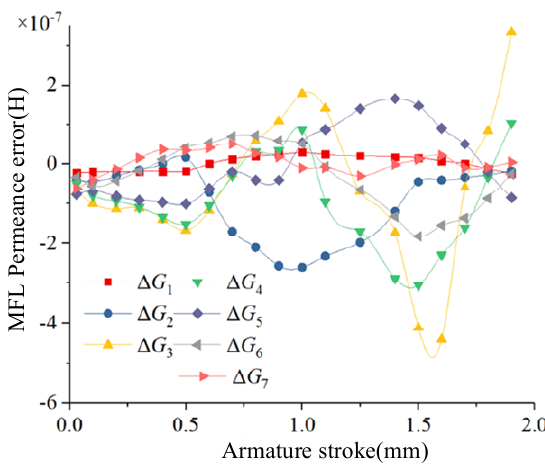
Figure 3. The leakage permeance error values in 0 AT.